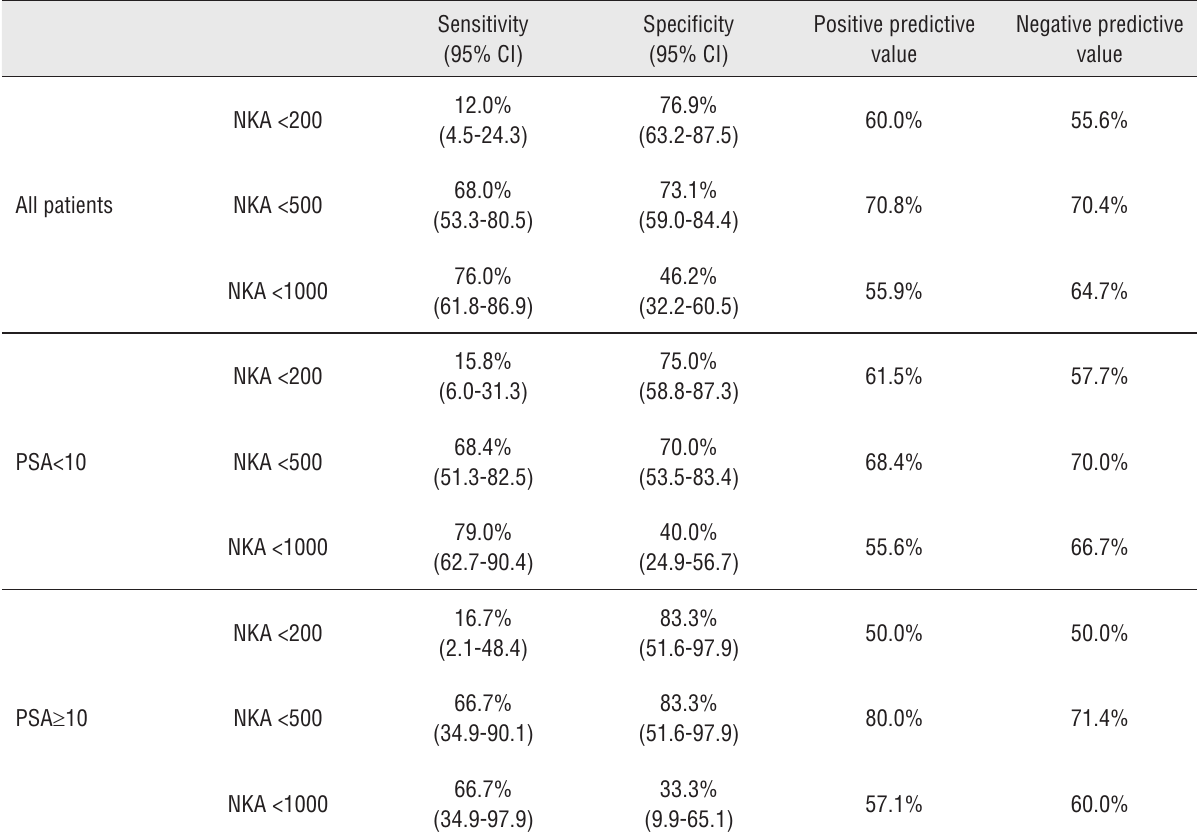
Table 3 - Sensitivity and specificity for the NK cell-cutoff.